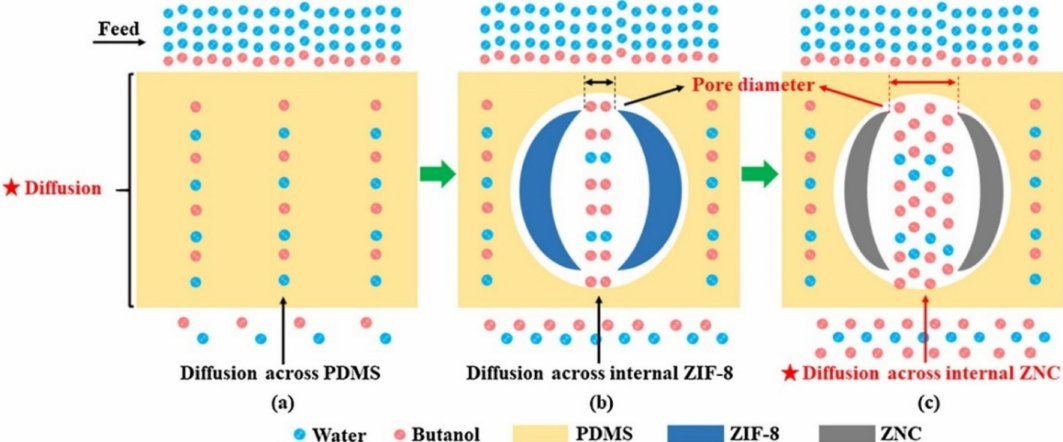
Figure 6. Illustration of the pure PDMS structure and the MMM and the main diffusion path of molecules. ( a ) The pure PDMS membrane; ( b ) The ZIF-8/PDMS MMM; ( c ) The ZNC/PDMS MMM [15]—(Reprinted from Separation and Purification Technology, vol. 221, Z. Si, D. Cai, S. Li, G. Li, Z. Wang, and P. Qin, “A high-efficiency diffusion process in carbonized ZIF-8 incorporated mixed matrix membrane for n-butanol recovery”, pp. 286–293, Copyright (2021), with permission from